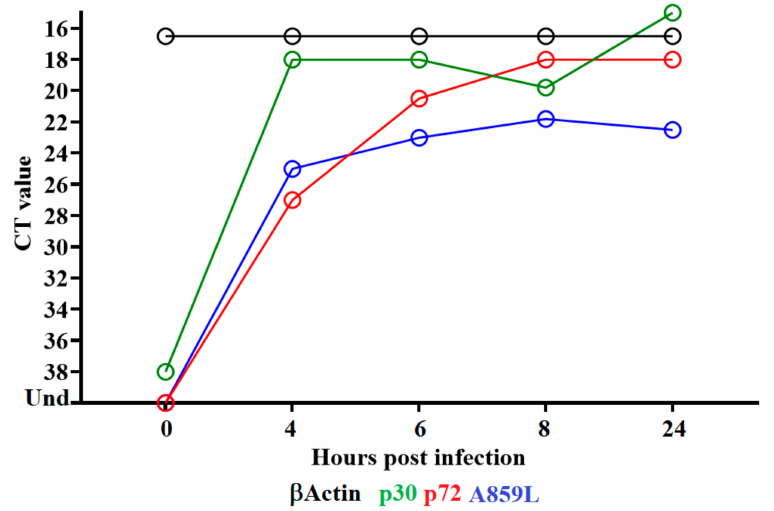
Figure 1. Expression profile of A859L gene of ASFV during in vitro infection of porcine macrophages. Reverse transcription followed by qPCR was used to evaluate the expression profile of the A859L gene during in vitro infection at different time points, up to 24 h. As a reference for this analysis, we use qPCRs to specifically detect the expression of genes encoding ASFV proteins p30 (early expression) and p72 (late expression). Additionally, the β -Actin gene was used as a control to evaluate the quality and levels of RNA during the infection at different time